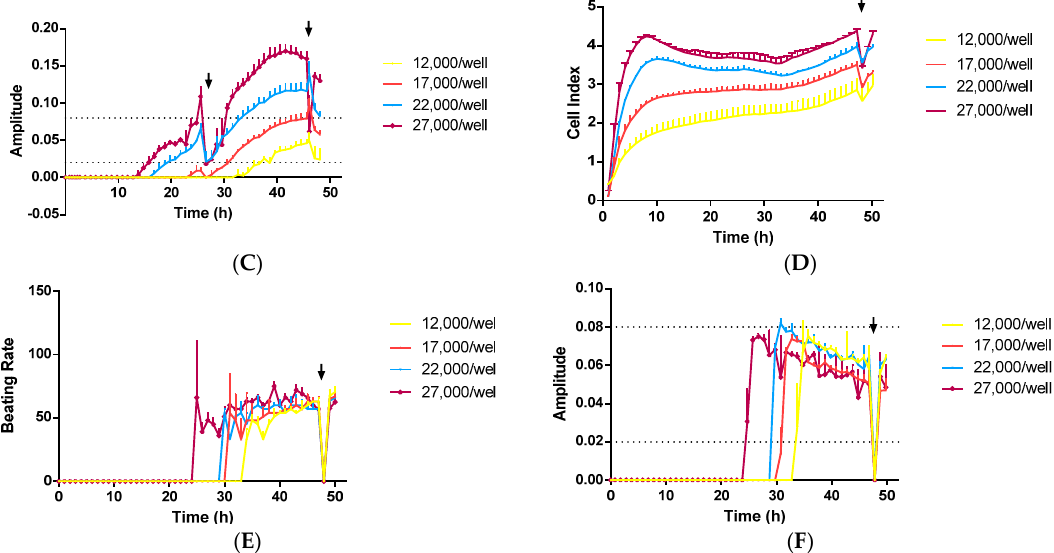
Figure 1. Optimization of Rat neonatal and hiPS cardiomyocytes seeding density on RTCA system. ( A ) Cell index; ( B ) Beating rate and ( C ) Amplitude of rat neonatal CMs within 48 h after seeding; ( D ) Cell index; ( E ) Beating rate and ( F ) Amplitude of hiPS-CMs. The black arrows indicated the time point of fresh medium addition. Data were presented as mean ± SD, n = 10.